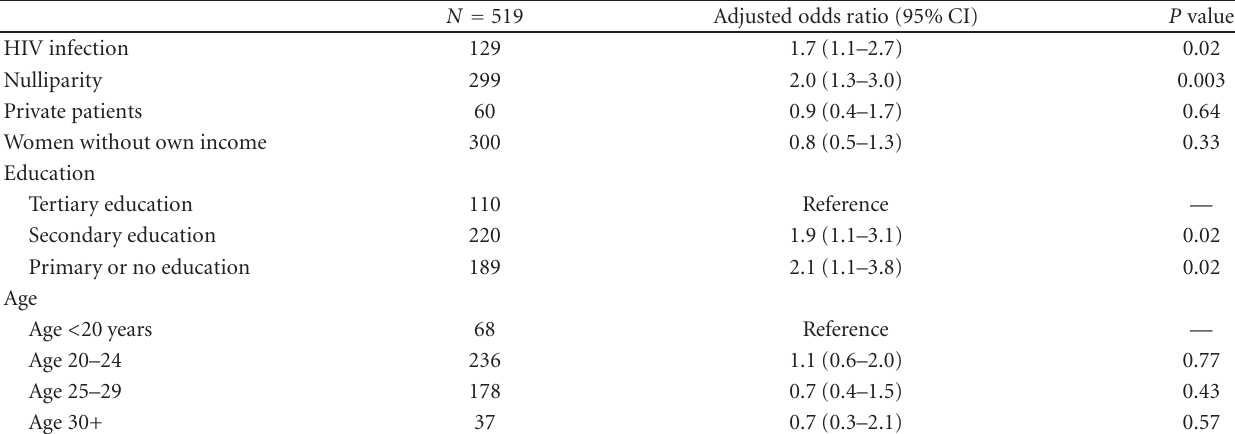
Table 3: Major morbidity due to HIV infection adjusted for selected demographic